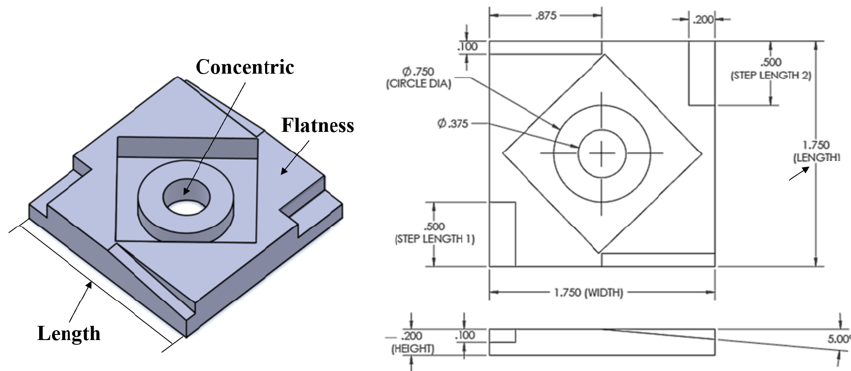
Figure 3. Standard drawing of NAS 979 part (unit: inch)